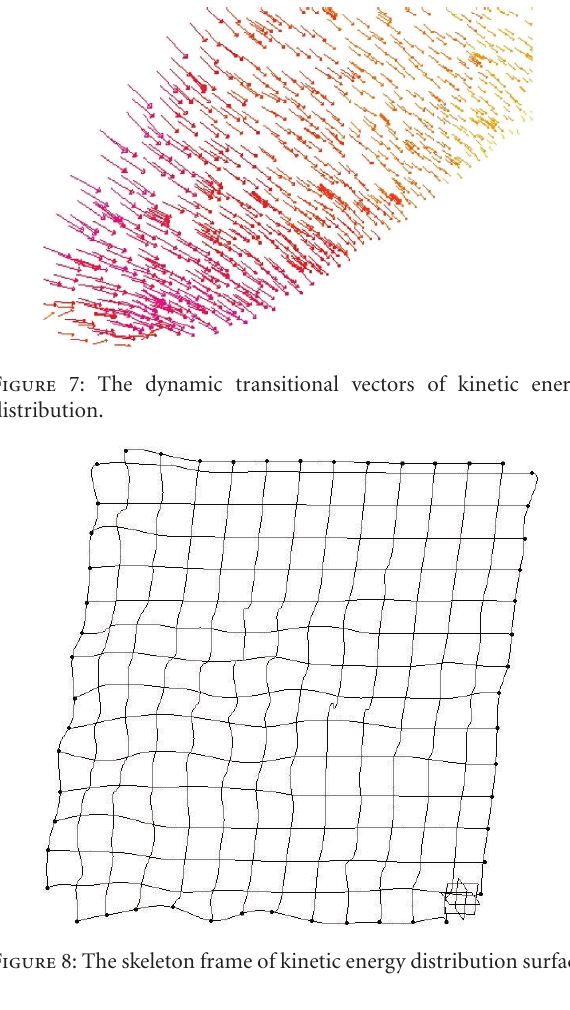
curves, we use u and v axes to denote the transverse and lon- gitudinal orientations with their value scales being [0,4000] and [0,5000], respectively, (um). Simultaneously, as the